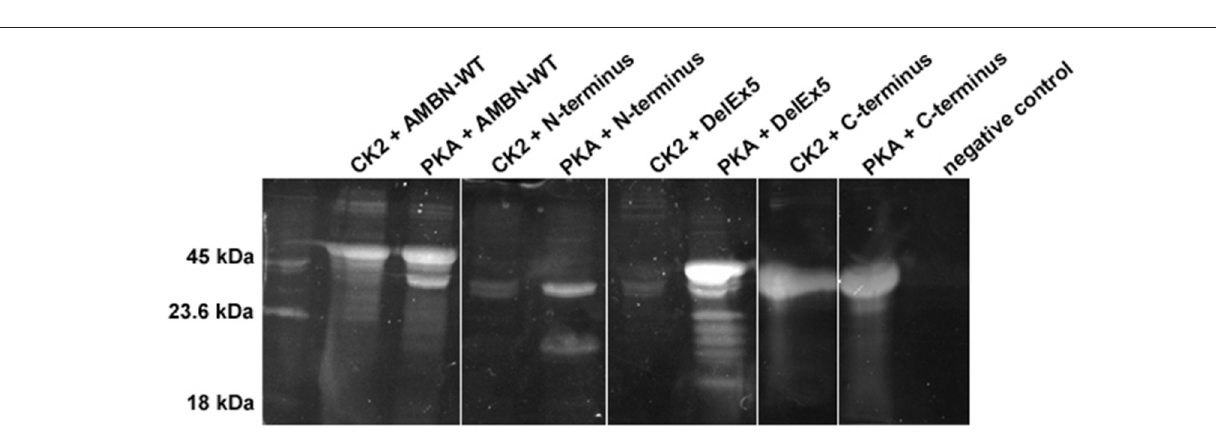
peptides encoded by exon 5 influence differentiation of